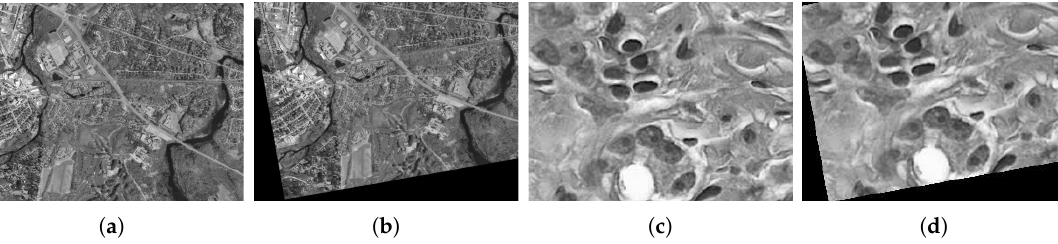
Figure 17. Concord image pair and Hestain image pair. ( a ) Concord reference image. ( b ) Concord sensed image. ( c ) Hestain reference image. ( d ) Hestain sensed